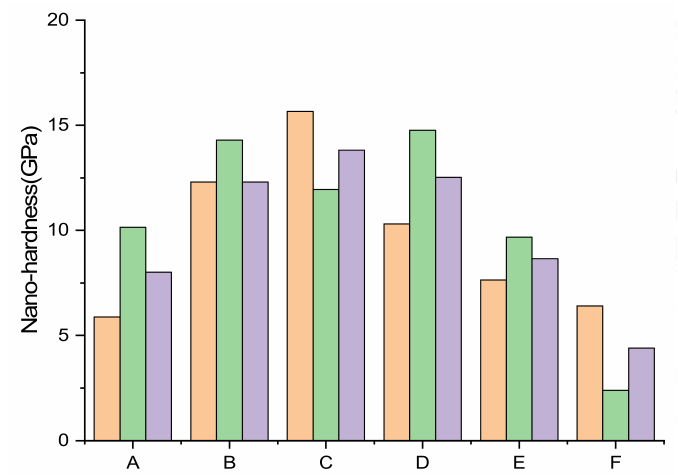
Figure 10. Distribution range of hardness test values in bright-white area.